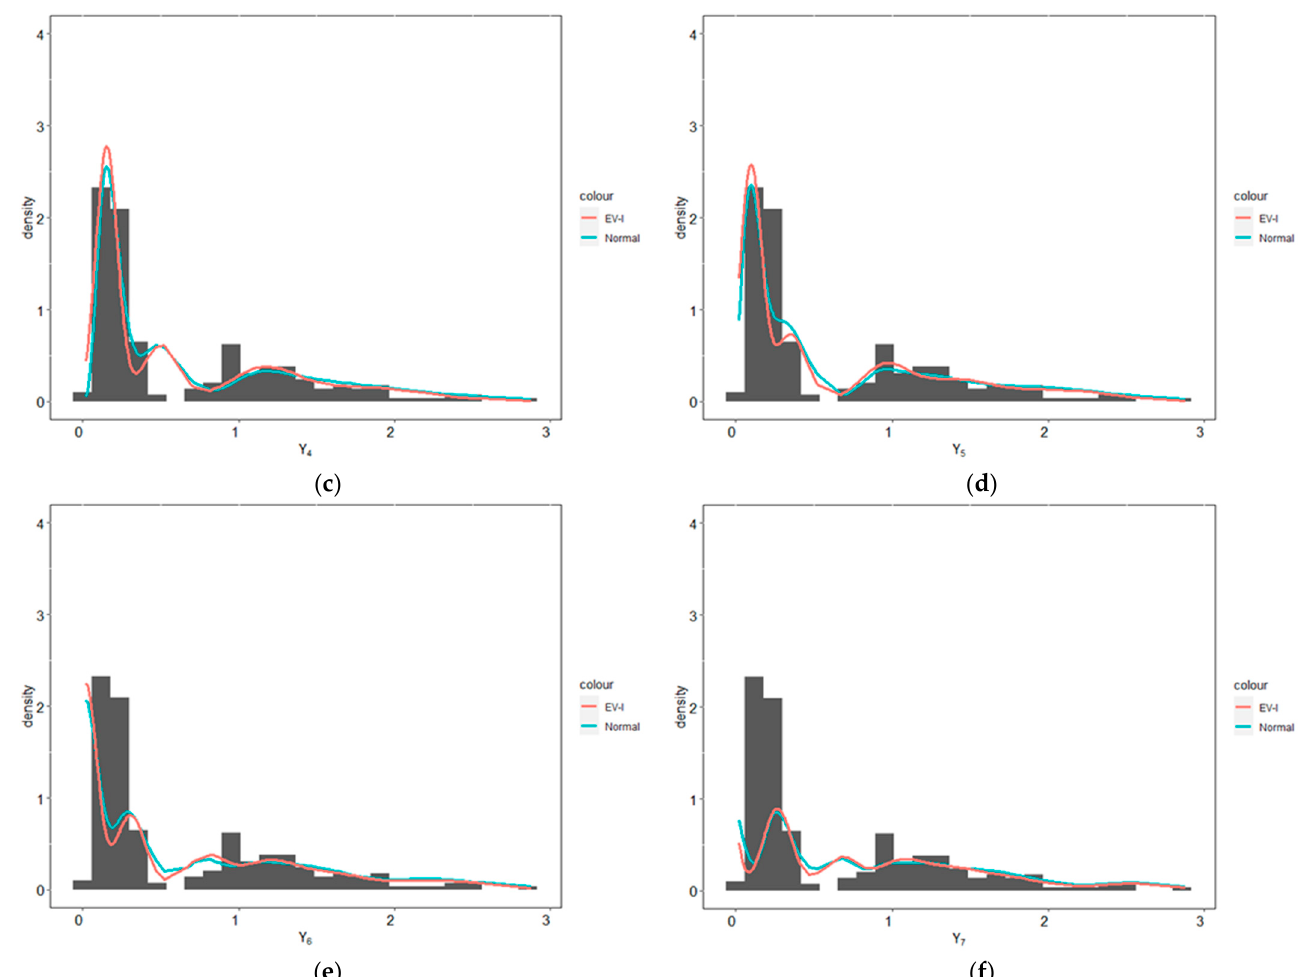
Figure 6. Predictive densities for enzyme data using the EV-I mixture and the Gaussian mixture distributions with ( a ) two components, ( b ) three components, ( c ) four components, ( d ) five components, ( e ) six components, and ( f ) seven components.